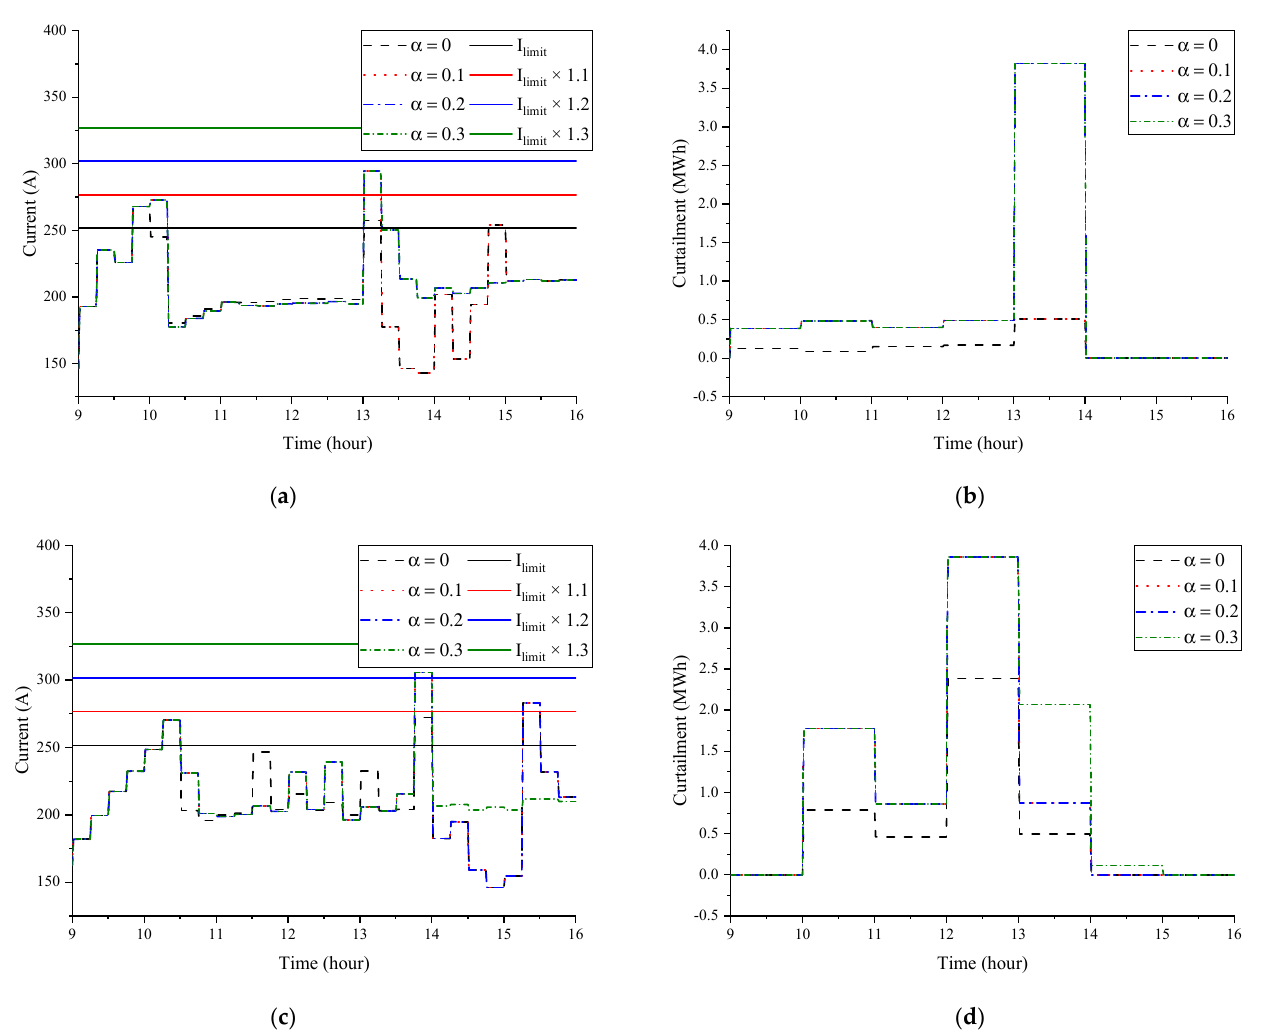
Figure 17. Maximum current and curtailment with respect to α on Days 4 and 33: ( a ) maximum current before control on Day 4; ( b ) curtailment on Day 4; ( c ) maximum current before control on Day 33; ( d ) curtailment on Day 33.